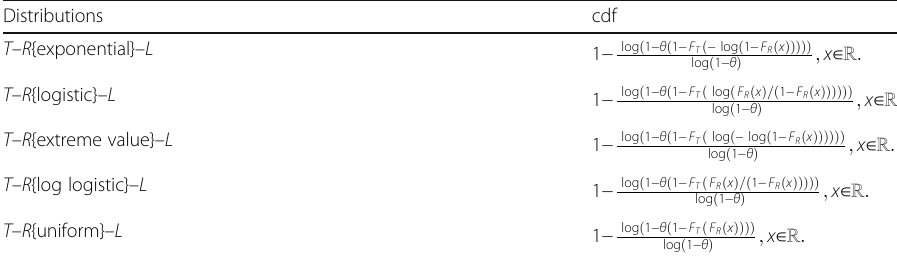
Table 6 Different T – R { Y } – L distributions Distributions